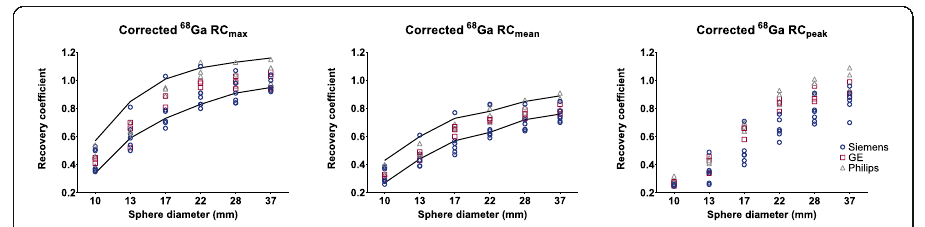
Fig. 4 68 Ga RC-curves corrected for the 18 F/ 68 Ga calibration mismatch according to local cross-calibration. Solid lines: maximum and minimum values according to EARL limits as applicable before